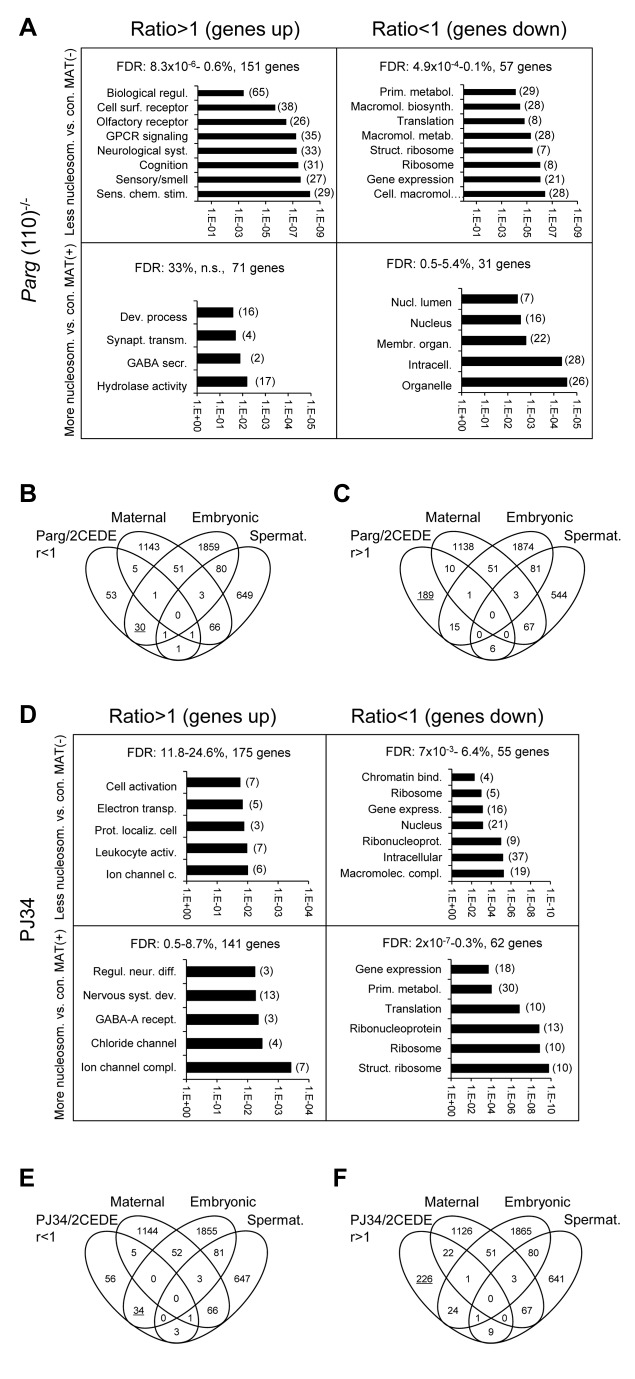
Genes that are affected by altered sperm histone association and differential gene expression in 2-cell embryo progeny in the Parg(110)−/− (A, B, C) and PJ34-treated (D, E, F) mouse models share some common functional relevance.Analyses of functional ontology of genes that are both affected by elevated (MAT(+)) or lower (MAT(−)) differential histone association in sperm and differential expression in resulting embryos (2CEDE/MND) were performed in the Parg(110)−/− (A) or PJ34 (D) model system. Genes are listed according to up- (ratio>1) or down (ratio<1) regulation compared to controls in offspring from Parg(110)−/− or PJ34 treated males and p-values of the GO terms (DAVID) associated with the corresponding group of genes are given on the logarithmic x-axis. The number of genes in each GO functional category is in parentheses. FDR: false discovery rates. (B, C, E, F) Comparing lists of genes that were either down-regulated (B, E) or up-regulated (C, F) in offspring of Parg(110)−/− or PJ34 treated males compared to controls (taken from (A) or (D)) to lists of genes of known embryonic [37], or maternal [36], origin demonstrated that maternal transcripts left over from the zygote were largely unchanged. Down-regulated transcripts (ratio<1) in 2-cell embryos of fathers with perturbed PAR metabolism were mostly of embryonic, but not maternal origin (B, E). Up-regulated genes are those that are not normally expressed during this phase of embryo development (C, F, underlined). These genes appear precociously expressed here and are normally only active after the blastocyst stage of development.